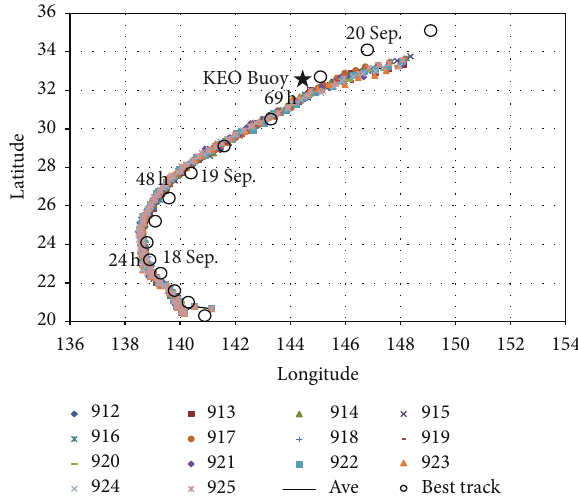
Figure 3: Best-track positions of Typhoon Choi-wan shown every 6 h, the hourly positions of central pressure obtained by each simulation, and the mean hourly position of central pressures averaged over all simulations. A star mark indicates the location of the KRO